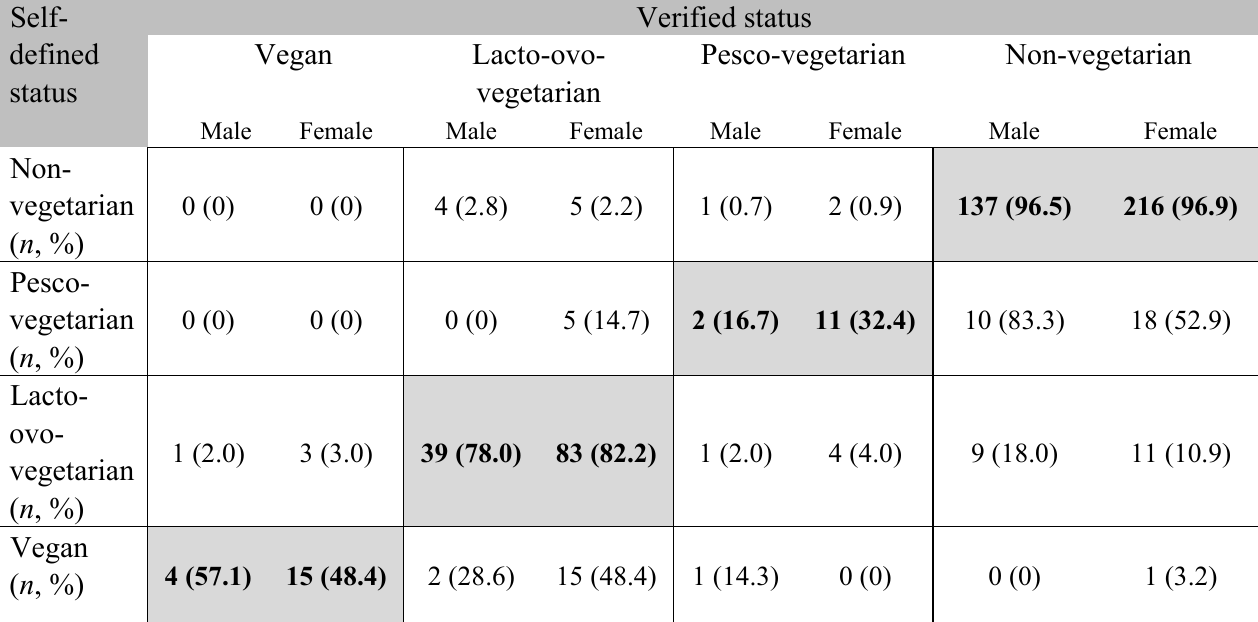
Table 3. Self-defined vs. Verified Vegetarian Status by Gender ( n =